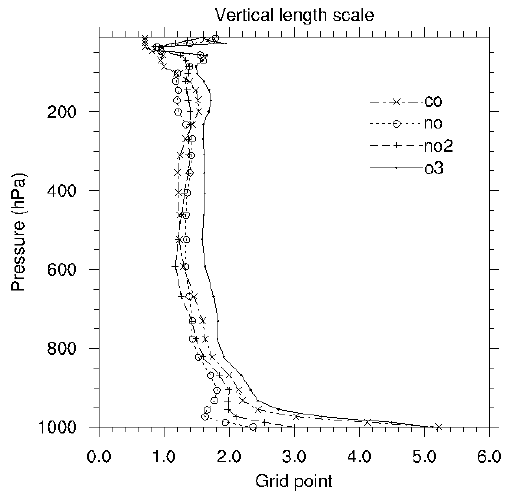
Figure 21. Vertical length scale of O 3 , NO 2 , NO, and CO (WRF- Chem, res. 36km,